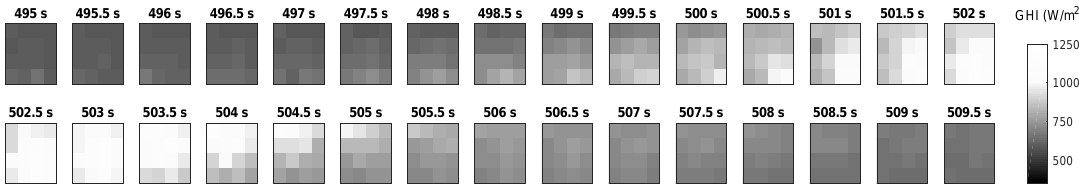
Figure 8. Irradiance field sequence of 15 s.